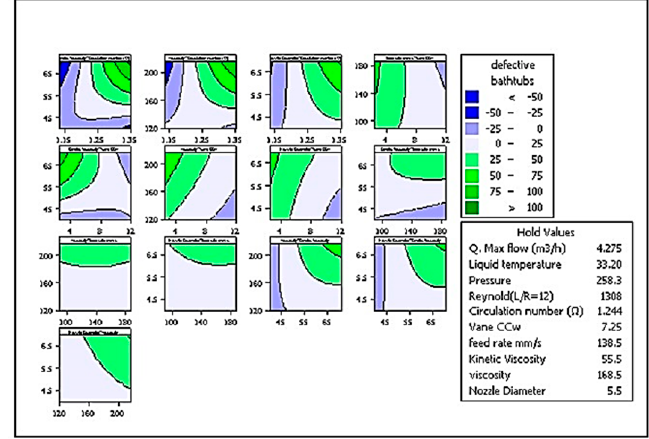
Figure 24. The contour plots of bubble creation causes using beginning values of NN runs.